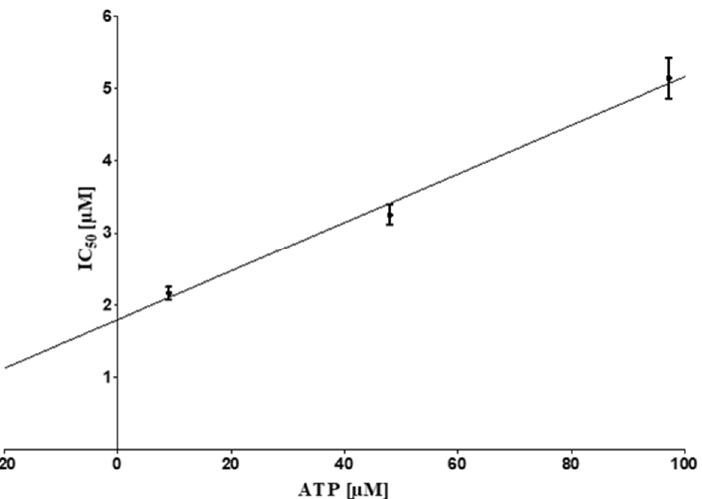
Figure 3. ATP-competitive inhibition of human CK2 by acetoxystachybotrydial acetate. IC 50 values with three different ATP concentrations were determined using nine different concentrations of the inhibitor ranging from 0.001 µM to 100 µM and plotted against the corresponding ATP concentrations. Each IC 50 value was determined three times independently. Mean values with standard deviation are given. The Ki value is defined as the Y-axis intercept and was determined to be 1.41 µM (R 2 = 0.97).